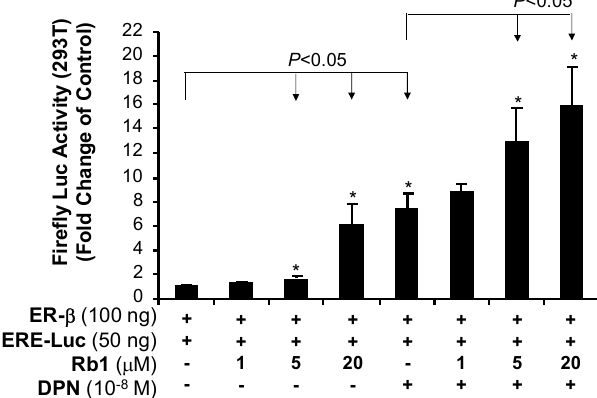
Figure 8. Direct effect of ginsenoside Rb1 and diarylpropionitrile (DPN) on ER- β activation in 293T cells. ER- β cDNA plasmid and ERE-Firefly luciferase reporter plasmid as well as Renilla luciferase reporter plasmid were co-transfected into 293T cells. ERE-Firefly Luciferase activities were normalized with internal control of Renilla luciferase activities. Ginsenoside Rb1 or/and DPN activated ER- β and reporter gene expression in 293T cells, indicating that both Rb1 and DPN can directly activate ER- β for a genomic response. ER- β activation data were standardized with the untreated control group as 1. Student’s t -test was used to compare the control with the treated group or between two groups. * p < 0.05. n = 3/group. ER- β (estrogen receptor β ); DPN (specific ER- β activator); ERE (estrogen responsive element); 293T cells (cell line derived from human embryonic kidney